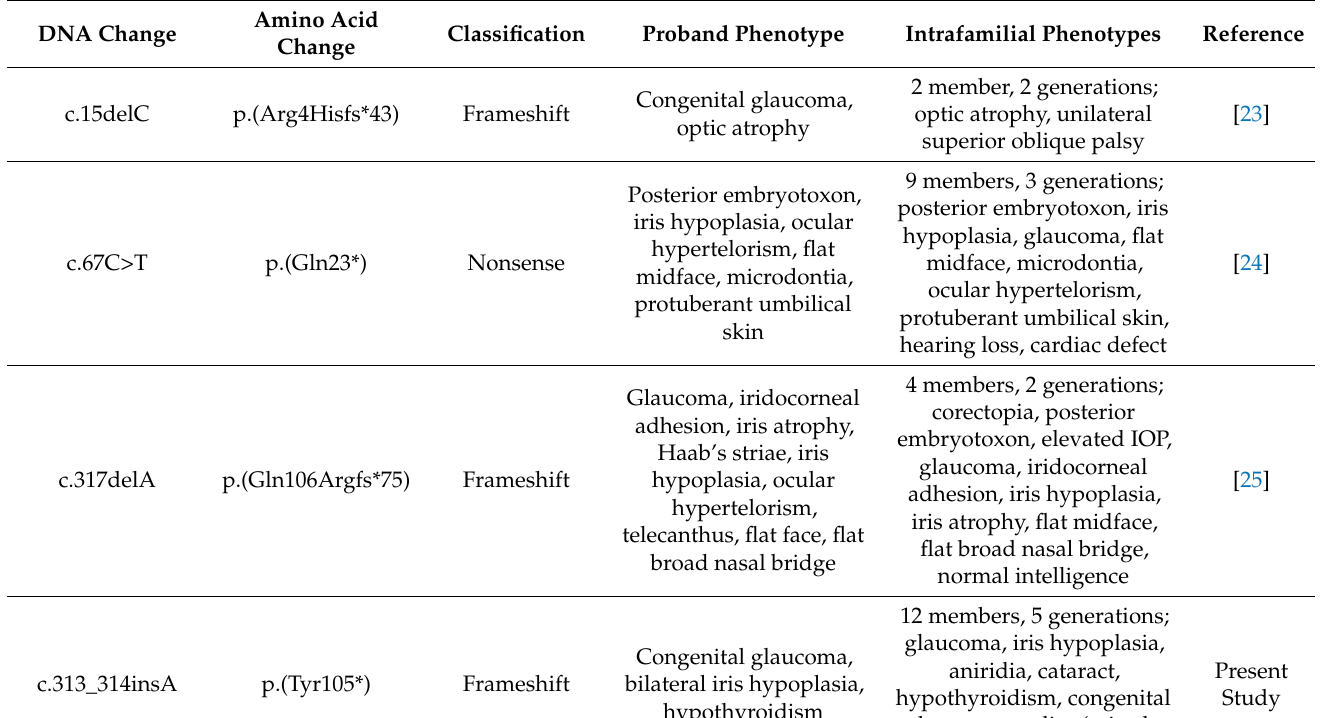
Table 1. Compilation of the genetic and phenotypic information related to truncating variants associated with FOXC1 segregating within multiple family